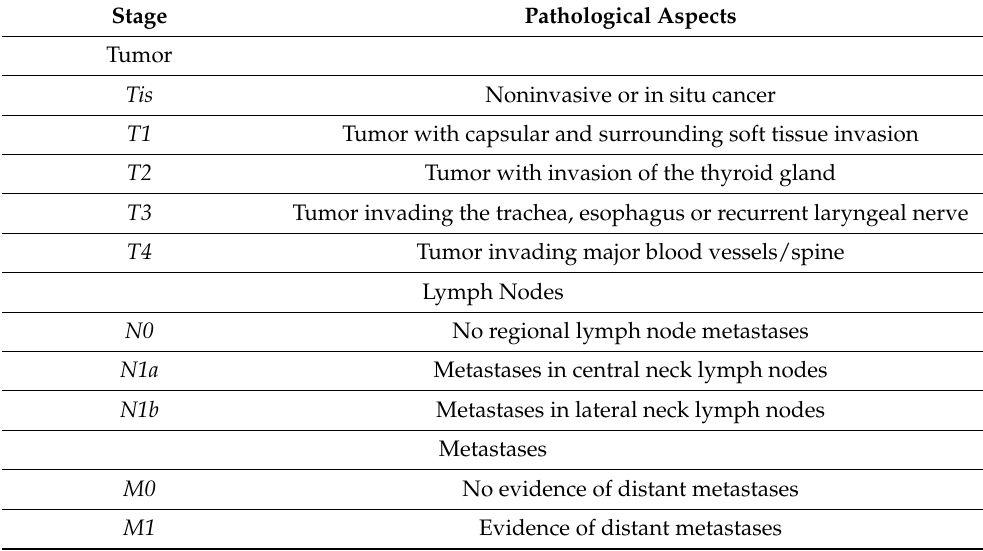
Table 3. Parathyroid cancer TNM staging system according to 2017 new edition of AJCC